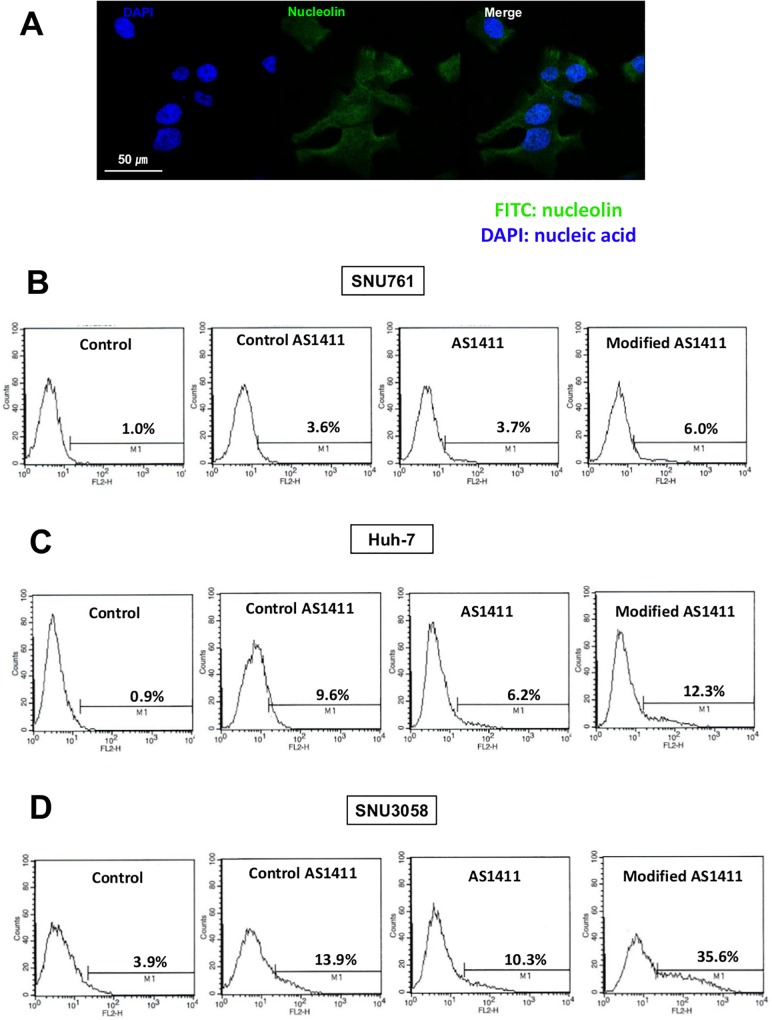
Nucleolin expression in HCC cells.(A) Nucleolin (green fluorescence) was present on the surface of SNU-761 cells based on fluorescence microscopy. (B−D) Flow cytometry analysis of cells immunostained with Cy-3 (1:400, 100 nM) showed that AS1411- and modified AS1411-aptamers had relatively higher affinity to SNU-761 (B), Huh-7 (C) and SNU3058 cells (D) compared to control.